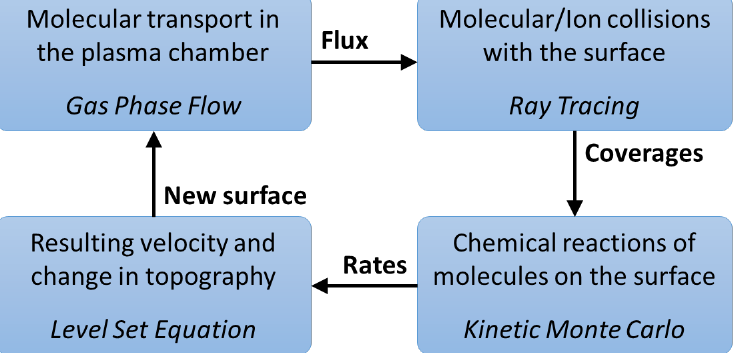
Figure 1. Schematic representation of the employed simulation flow. The starting point is obtaining fluxes which capture particle transport in the plasma chamber. The fluxes are then used to obtain the particle fluxes which impinge on each surface element and to calculate their coverage, which in turn serves as an input for modeling reactions on the surface. Reactions at the surface produce rates which are used to obtain velocities and move (advect) the surface by solving the level set